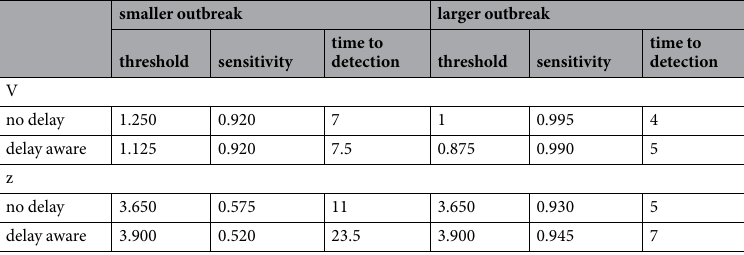
Table 1. Performance of the system under the V- and z-based approach, given the lowest alarm threshold resulting in a maximum in-control run length of 336